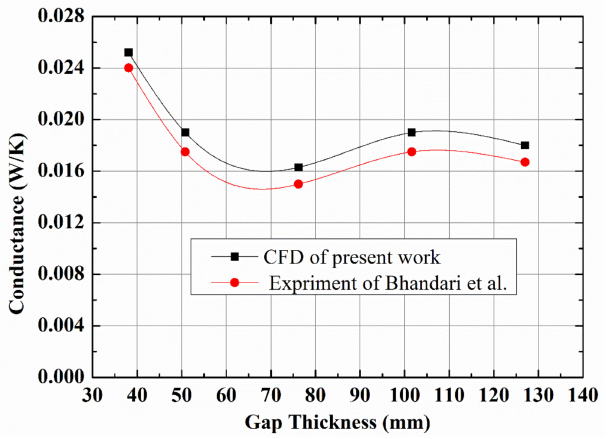
Figure 2. Comparison of thermal conductance between the present study and the literature [30].